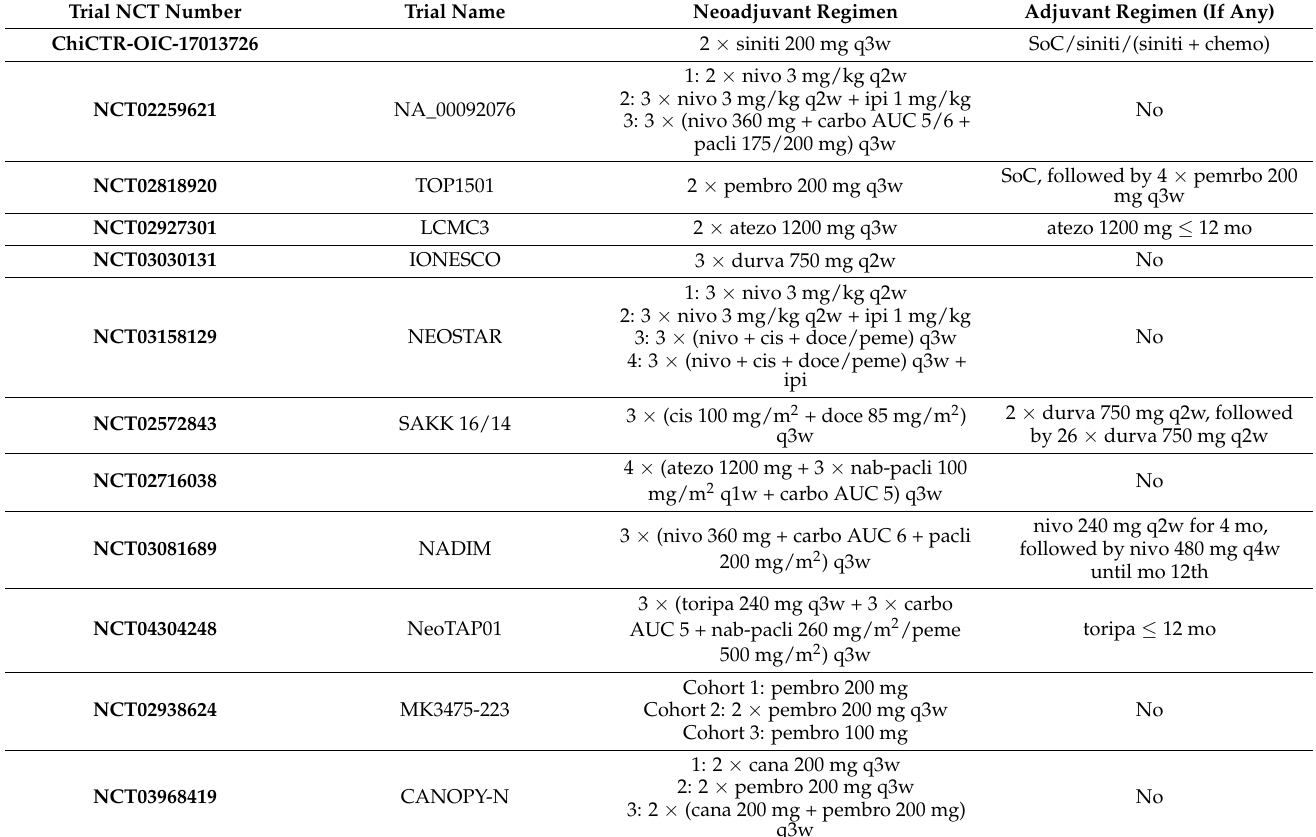
Table 5. Treatment regimens of selected clinical trials that included neoadjuvant immunotherapy in resectable NSCLC. Trial NCT